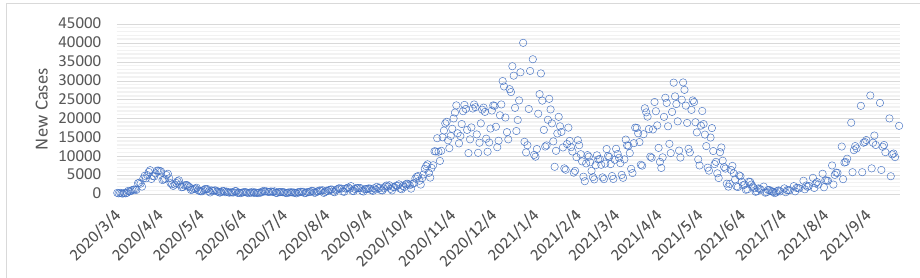
Figure 9. New cases of COVID-19 on selected days: ( a ) 04 March 2020 ( b ) 12 May 2020 ( c ) 12 August 2020 ( d ) 12 November 2020 remaining maps available in Figure A1. A gradual increase in new cases is noticeable over time. This was confirmed by the chart of new cases according to the data acquired from the Koch Institute (Figure 10).